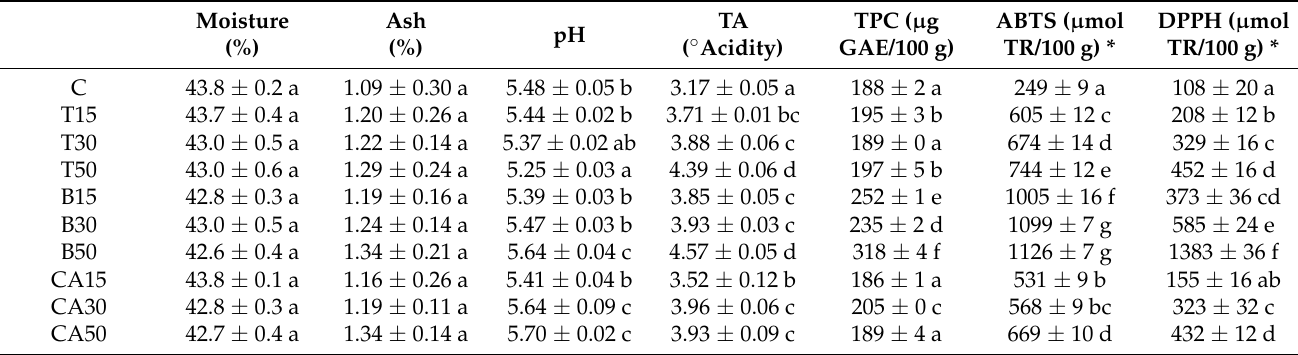
Table 4. Physicochemical and antioxidant properties of studied